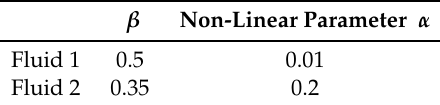
Table 1. Material parameters.